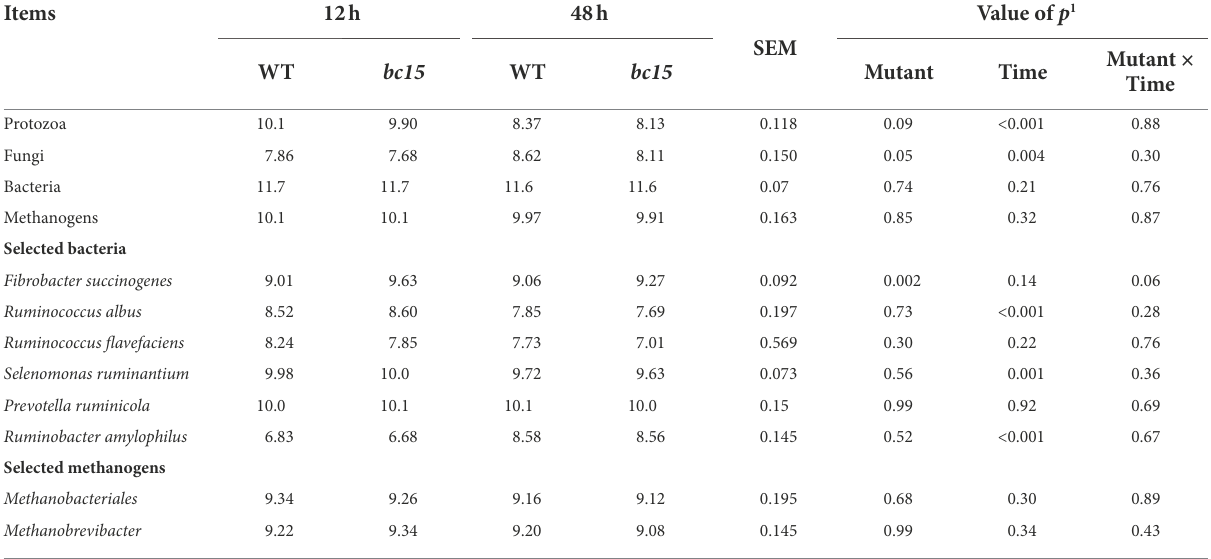
TABLE 6 Select microbial groups (determined by RT-PCR) of wild-type (WT) and brittle culm 15 ( bc15 ) mutant rice straws after 12- and 48-h in vitro ruminal incubation, log 10 (copies/ml; n = 3).